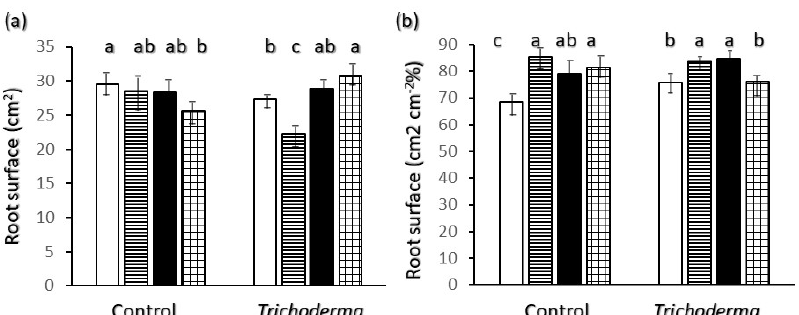
Figure 5. Interaction of wheat variety x Trichoderma harzianum T-22 inoculation on root surface in the diameter class < 0.5 mm: ( a ) total length of root structures; ( b ) percent length of root structures. Color code of bars: white = Ciclope; horizontal stripes = Creso; black = Saragolle; grid = Simeto. Vertical segments on each bar indicate standard deviation n = 3. Different letters on each bar designate significantly different values for p < 0.05 at the Tukey’s post hoc mean separation test.